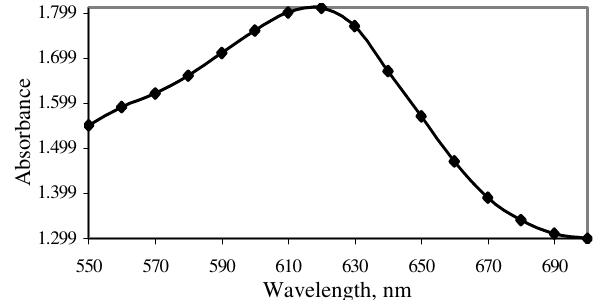
Figure 1. Absorbance obtained from different wavelength.